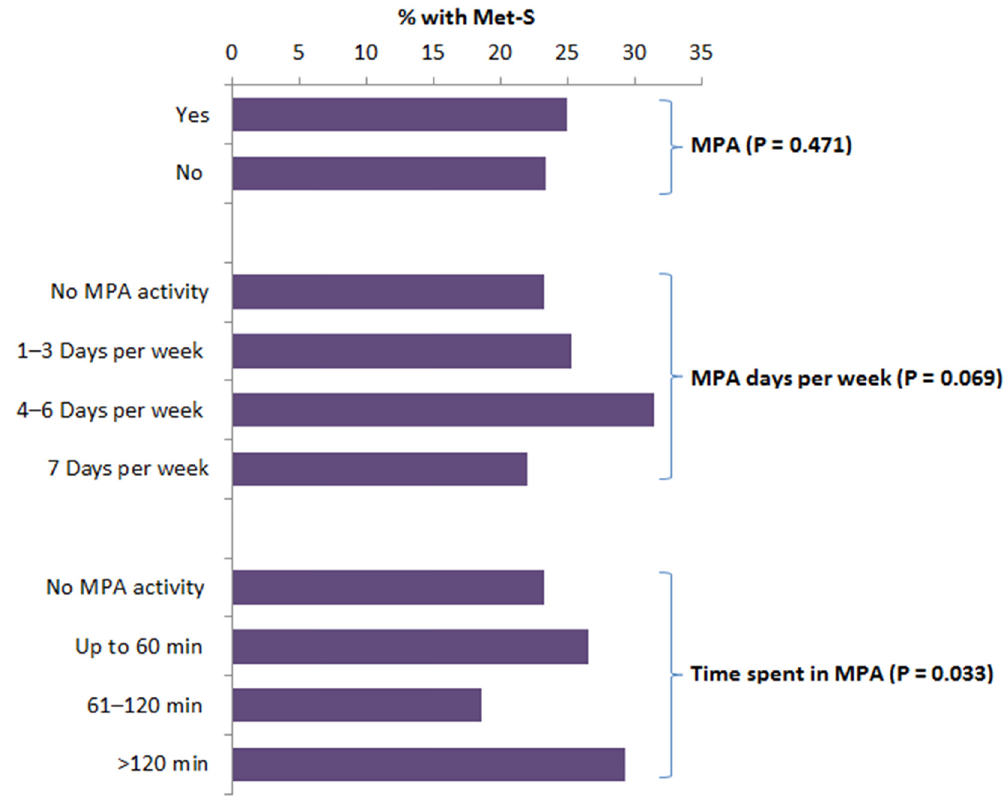
Figure 3: Association between MPA and Met - S. Values are percentage frequency of Met - S in the same